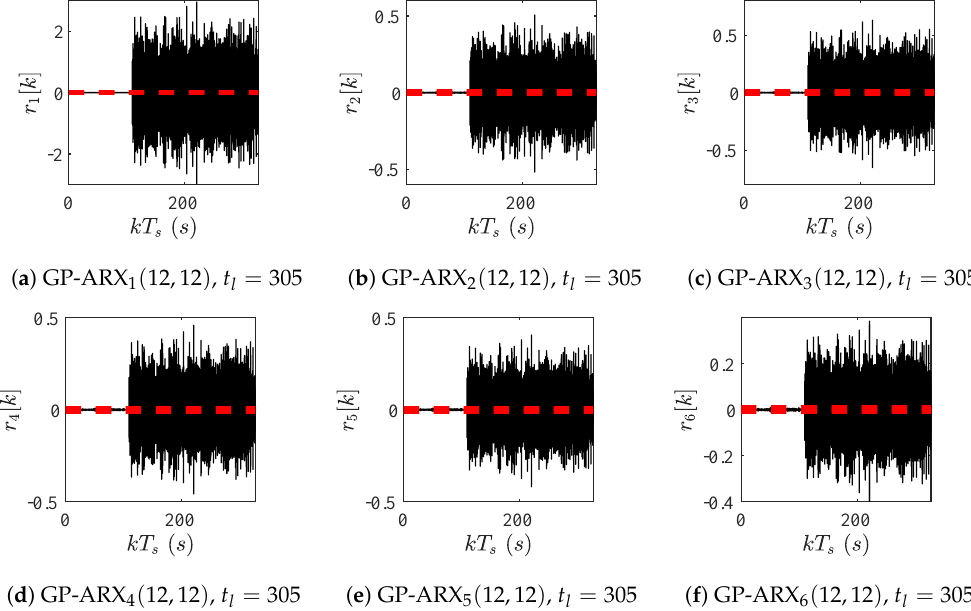
Figure 22. Shear frame: evolution of the residuals under 1% damage in K 1 , during a long time-scale instant from the validation set.